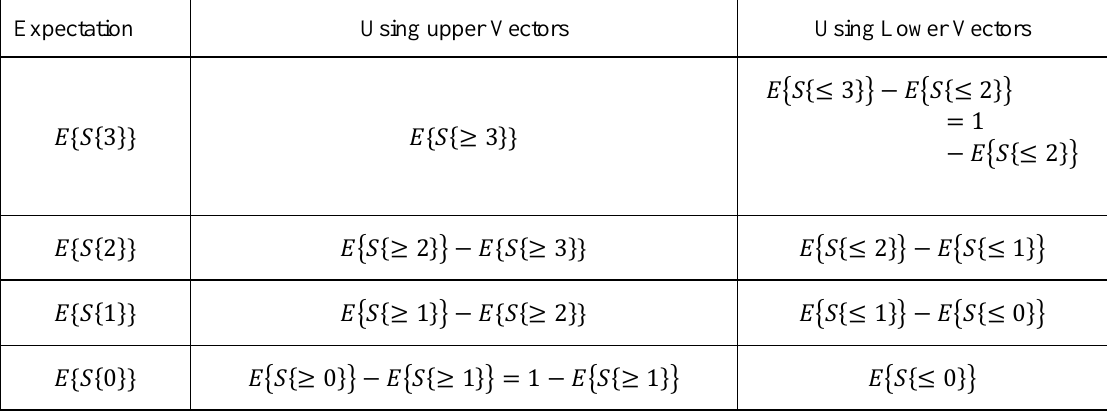
Table 4. Expectations of each instance of the multivalued system success 𝑆